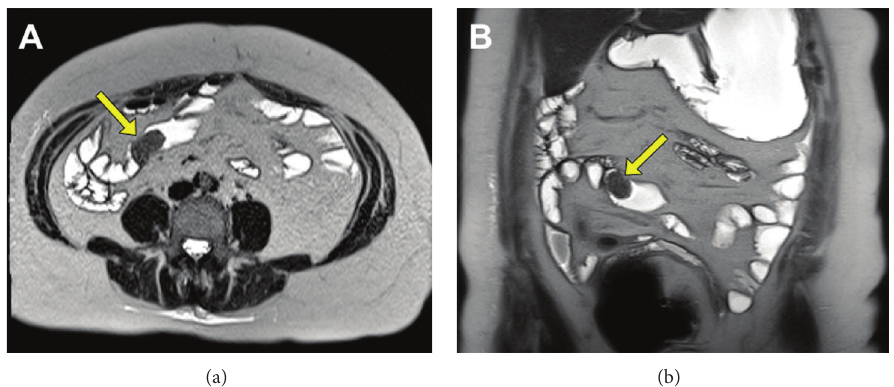
Figure 5: Axial (a) and coronal (b) MRE images with a large intraluminal (Peutz-Jeghers) polyp visible (yellow arrows).